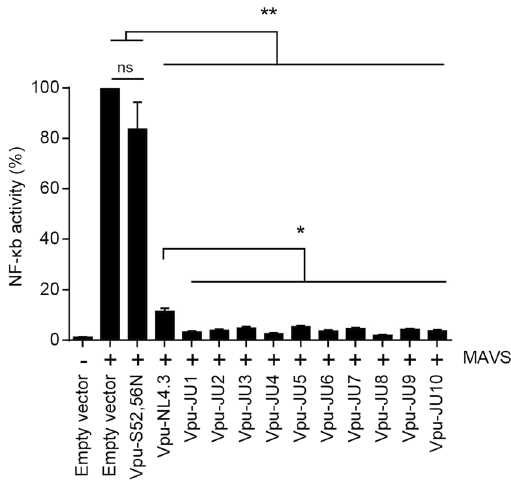
Figure 4. Inhibition of NF-kB by Vpu alleles. HEK293T cells were cotransfected with a vector for expression of MAVS as inducer of NF-kB and a firefly luciferase reporter construct controlled by five NF-kB binding